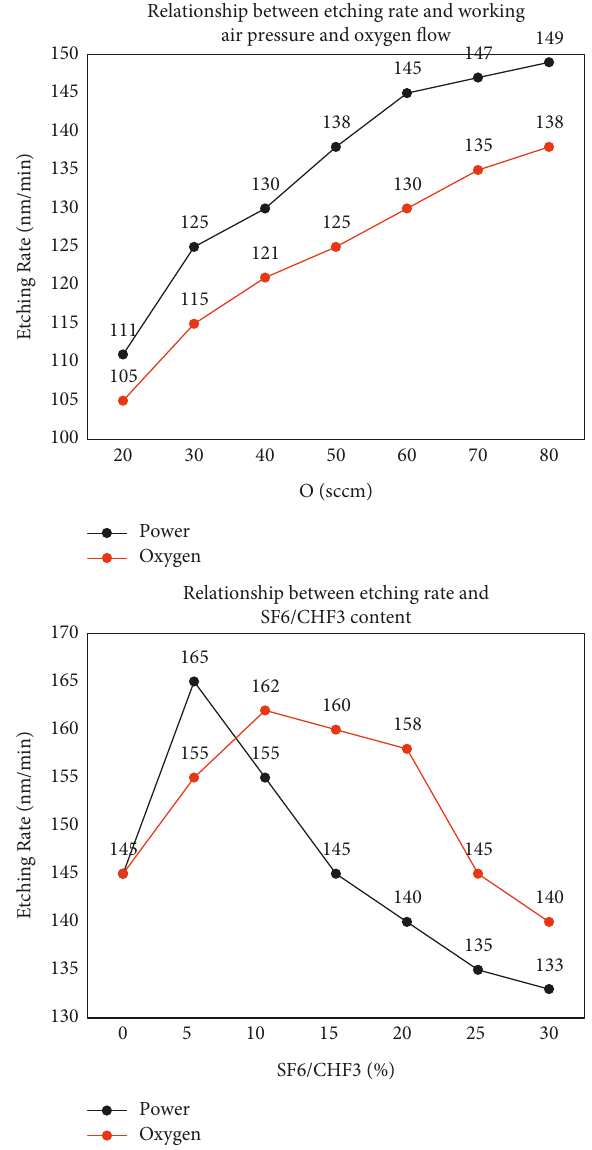
Figure 7: Relationship between etching rate and working pressure, oxygen content, and SF6 content. (a) Relationship between etching rate and working air pressure and oxygen flow. (b) Relationship between etching rate and SF6/CHF3 First, slowly increase the power supply voltage, the voltmeter at both ends of the arrester is close to the supply voltage, and the ammeter in the path is almost zero, that is,